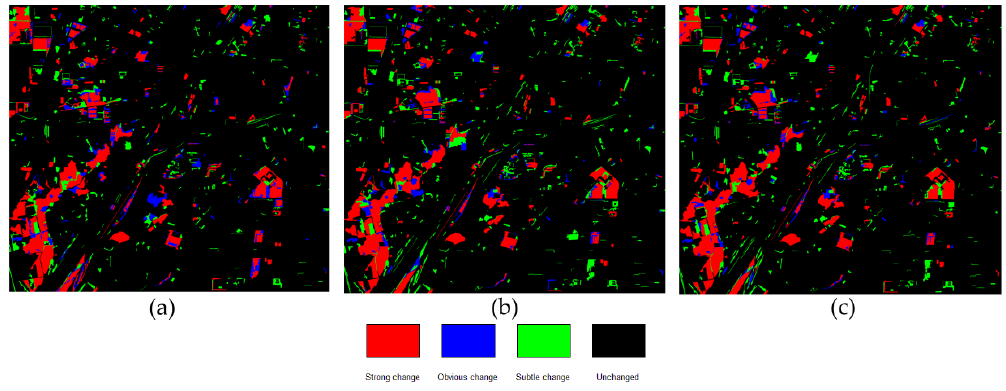
Figure 17. CD results obtained by majority voting. ( a ) ELM-MV; ( b ) RF-MV; ( c ) RoF-MV.